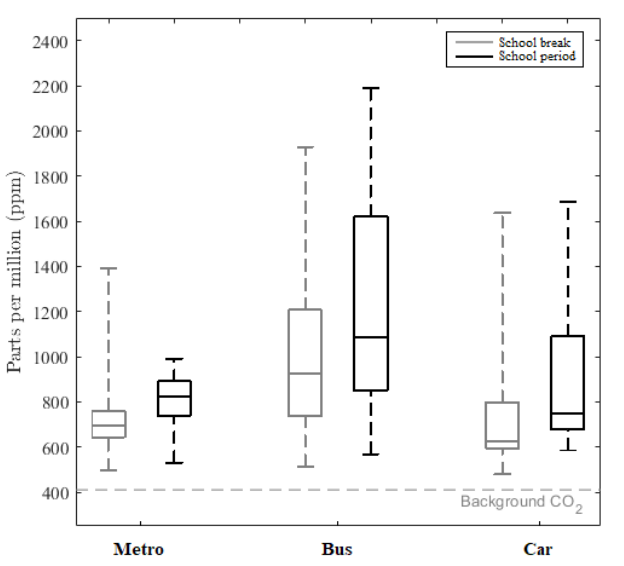
Figure 3. CO 2 level measurements comparison of school break and school period.